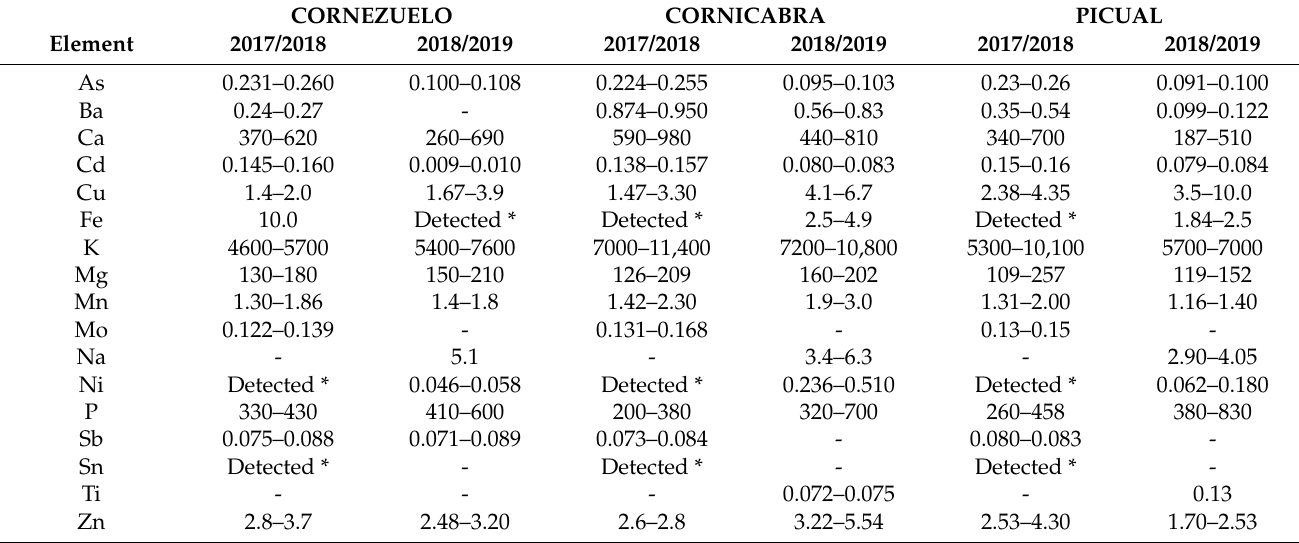
MS. Table 5 shows the ranges of concentration levels of minerals in fruits on the analysed cultivars at different harvest dates and crops seasons evaluated. The average concentration levels obtained in each olive variety are given in Supplementary Material in Tables S6–S8. The differences observed in the different HDs and harvesting seasons are due to different humidity percentages, climatologic conditions and geographical locations. Taking into account that there were four HDs in season 2018/2019 and that phenolic concentrations were higher, the following discussion focuses on this season. Table 5. Concentrations of mineral in foods of the analysed olive cultivars at two different harvest seasons. CORNEZUELO